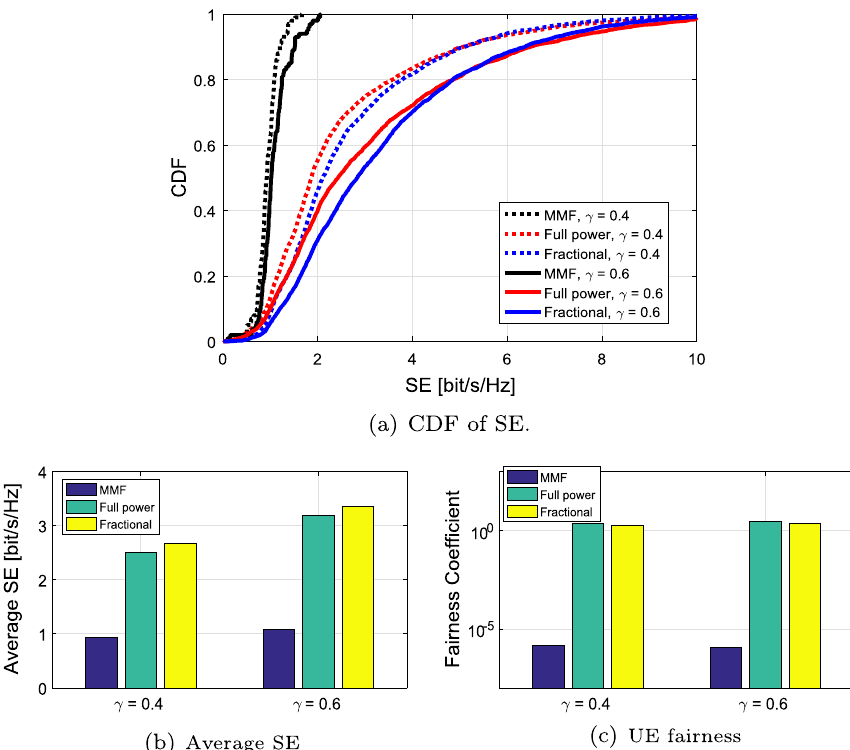
Fig. 6 The comparison of per-UE uplink SE, average SE and UE fairness with different power control schemes for the proposed location-aided combining scheme, where M = 8, N = 30, K = 30 and τ p =